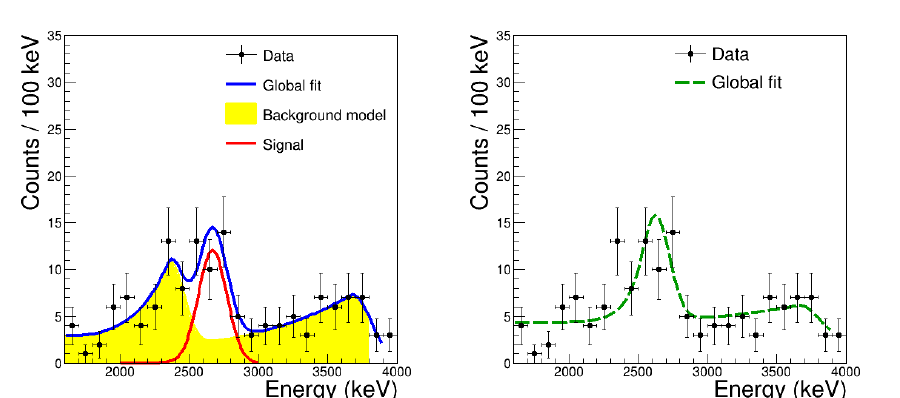
Figure 7. Using the PSD, the energy spectrum of α events from the acquired data with a CHC scintillator over 2848 h is shown. For the energy scale, the authors have considered the Q.F. of α particles (see text or Ref. [27] for details). ( left ) The fit of the data, in the energy region of interest, for the 174 Hf α decay. The fit model is built considering the α decays of 147 Sm, 174 Hf (red line) and taking into account some degraded alpha particles (online solid blue line). The yellow band is the background model. ( right ) The fit of the data by a modified model similar to the previous one but considering one peak (instead of two) in the energy (2.2–2.6) MeV (taken from Ref. [27] with